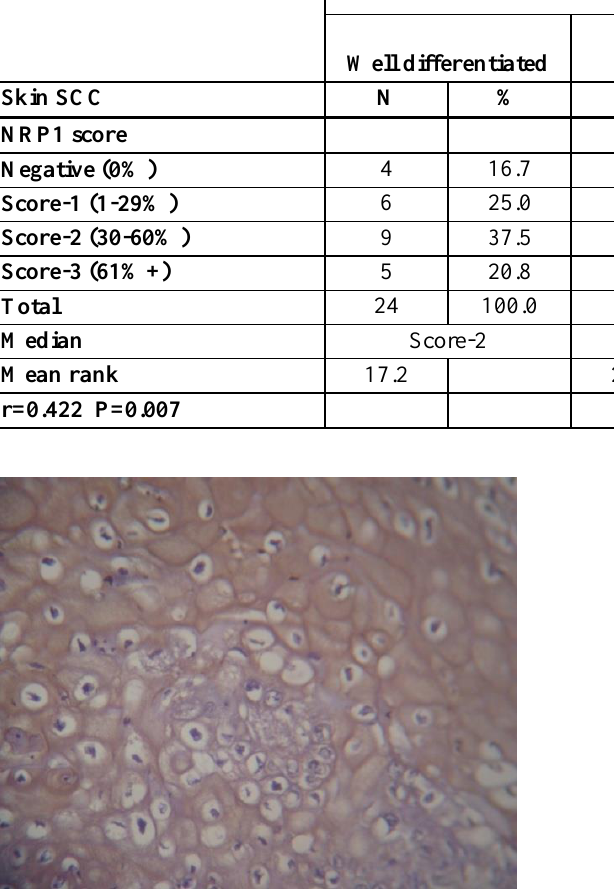
Table 6: The difference in median score category of selected NRP1 marker between the 3 tumor grades among cases with Skin SCC. Tumor grade Moderately Well differentiated differentiated Poorly differentiated